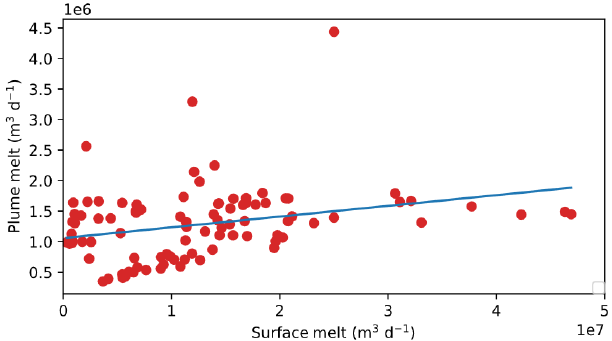
Figure 11. Scatter plot of surface melt versus plume melt for the SummerDaily17 run, showing low correlation. The line of best fit is shown in blue.